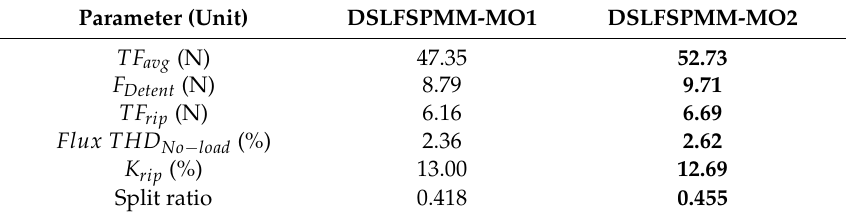
Table 8. Modified parameters and performance comparison of DSLFSPMM-MO1 with DSLFSPMM-MO2.